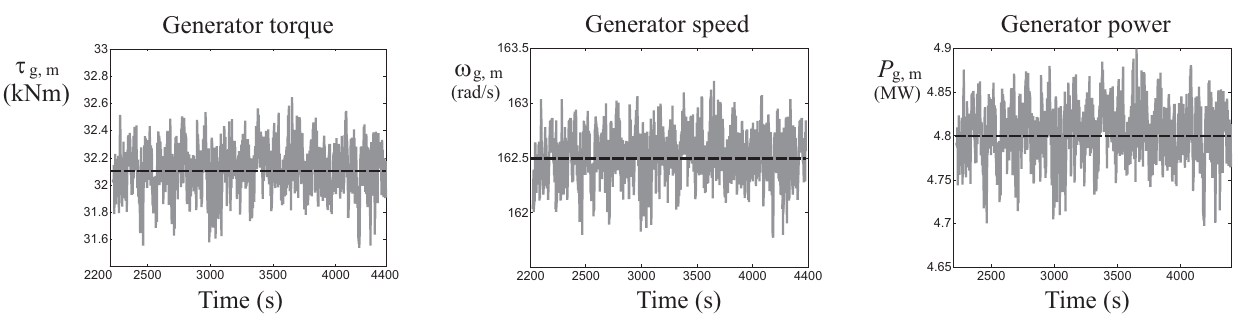
Figure 11. Variables of the WT benchmark in full load operation.